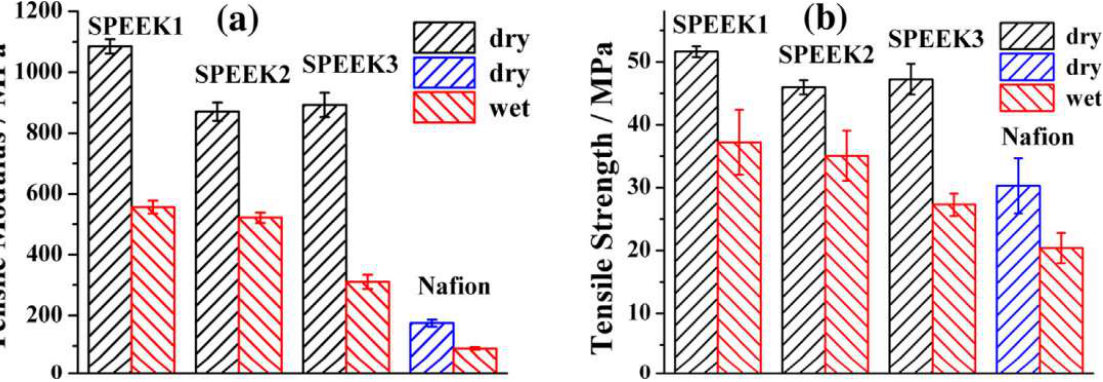
Figure 8. Nafion and SPEEK membranes in dry and wet state. ( a ) Tensile modulus and ( b ) tensile strength [71].